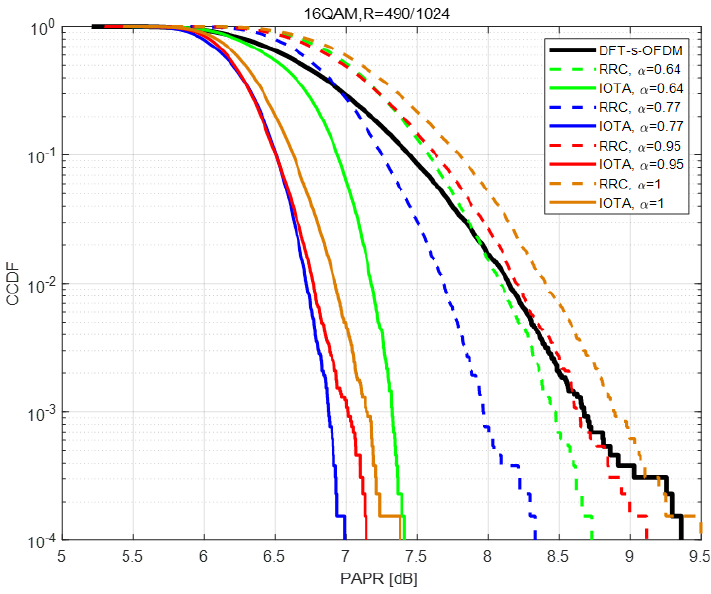
Figure 5. Performance of PAPR based on 16QAM with R = 490/1024.